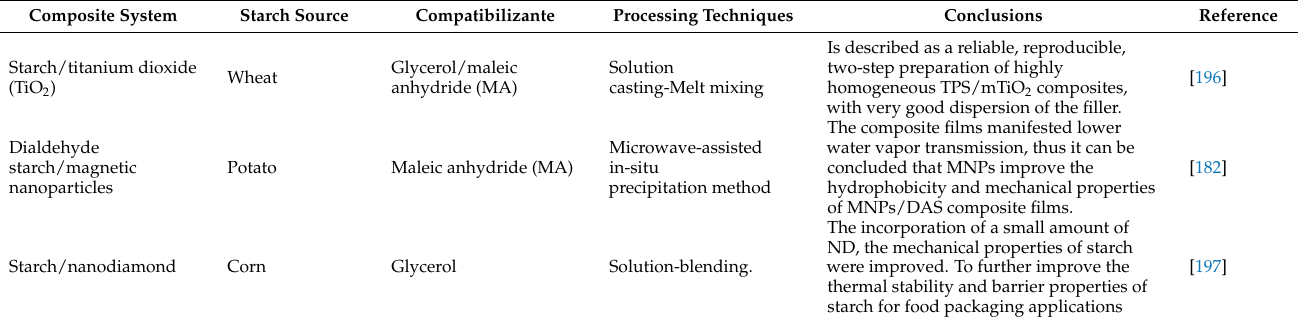
Table 5. Composite system, processing techniques and main results of starch based